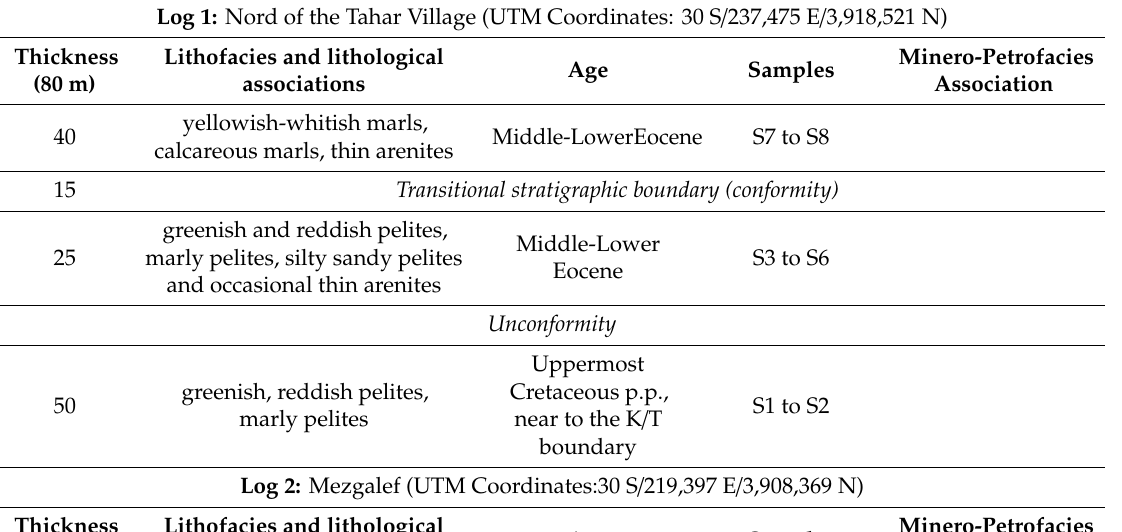
Table 1. Main field data (units, logs, localities, UTM coordinates, thickness, samples, boundary types, lithofacies and lithological associations) and laboratory results (ages, petrofacies and mineralogical associations). * Classification (NCE / CI / CE) according to Zu ff a [68,69]; ** Classification (QFL) according to Dickinson [66]; Zu ff a [68] and Ingersoll et al.